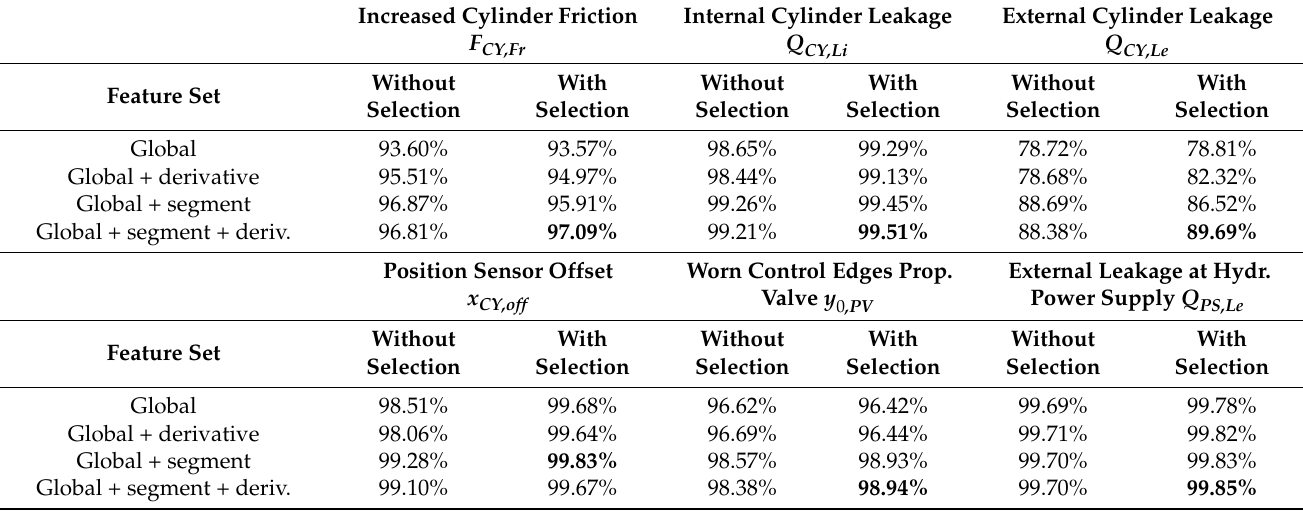
Table 2. Mean classification accuracies obtained with the best model during the grid search with and without feature selection, for different feature sets and for different faults. Best results for each fault are highlighted in